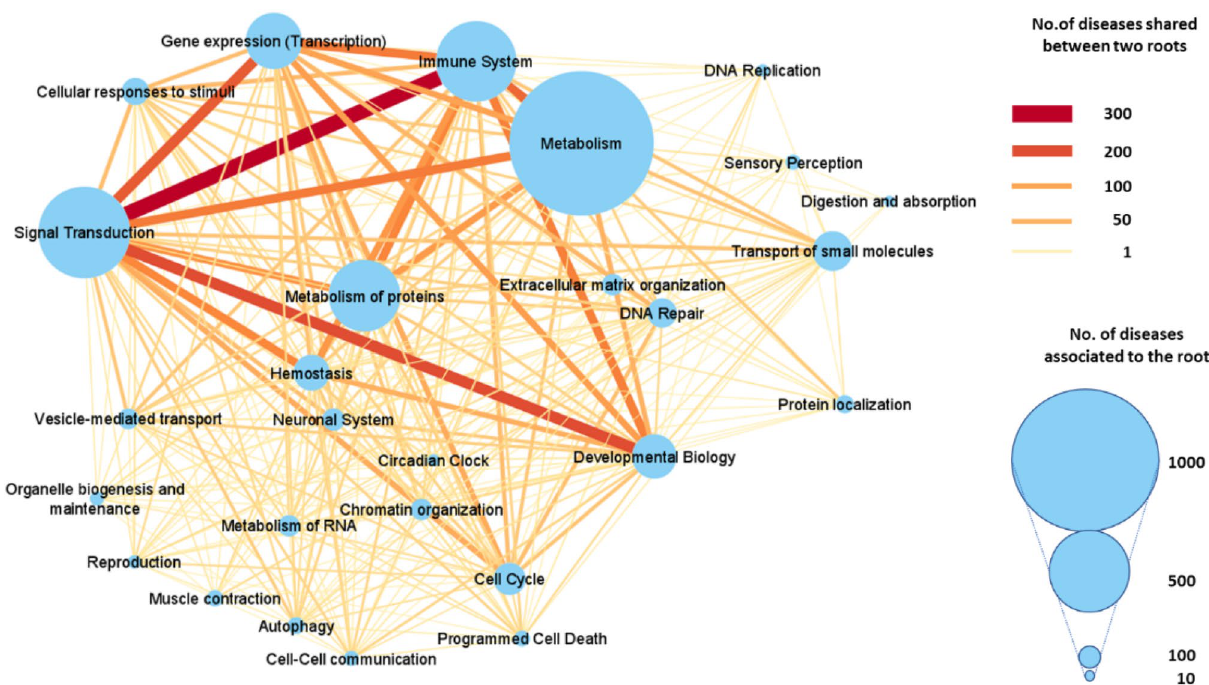
Figure 7. Disease Groups and their interactions. Network representation of the Reactome roots shared by the diseases in DAR. Each node represents a Reactome root, and its radius is proportional to the total number of diseases that associate to the root. Links represent the diseases that share Reactome roots. The wider and redder the link, the higher the number of connecting diseases. Diseases mapping in n (n ≥ 2) Reactome roots are counted for anyone of the possible n(n-1)/2 pairs. Cytoscape (https:// cytos cape. org/) was used for the graphical